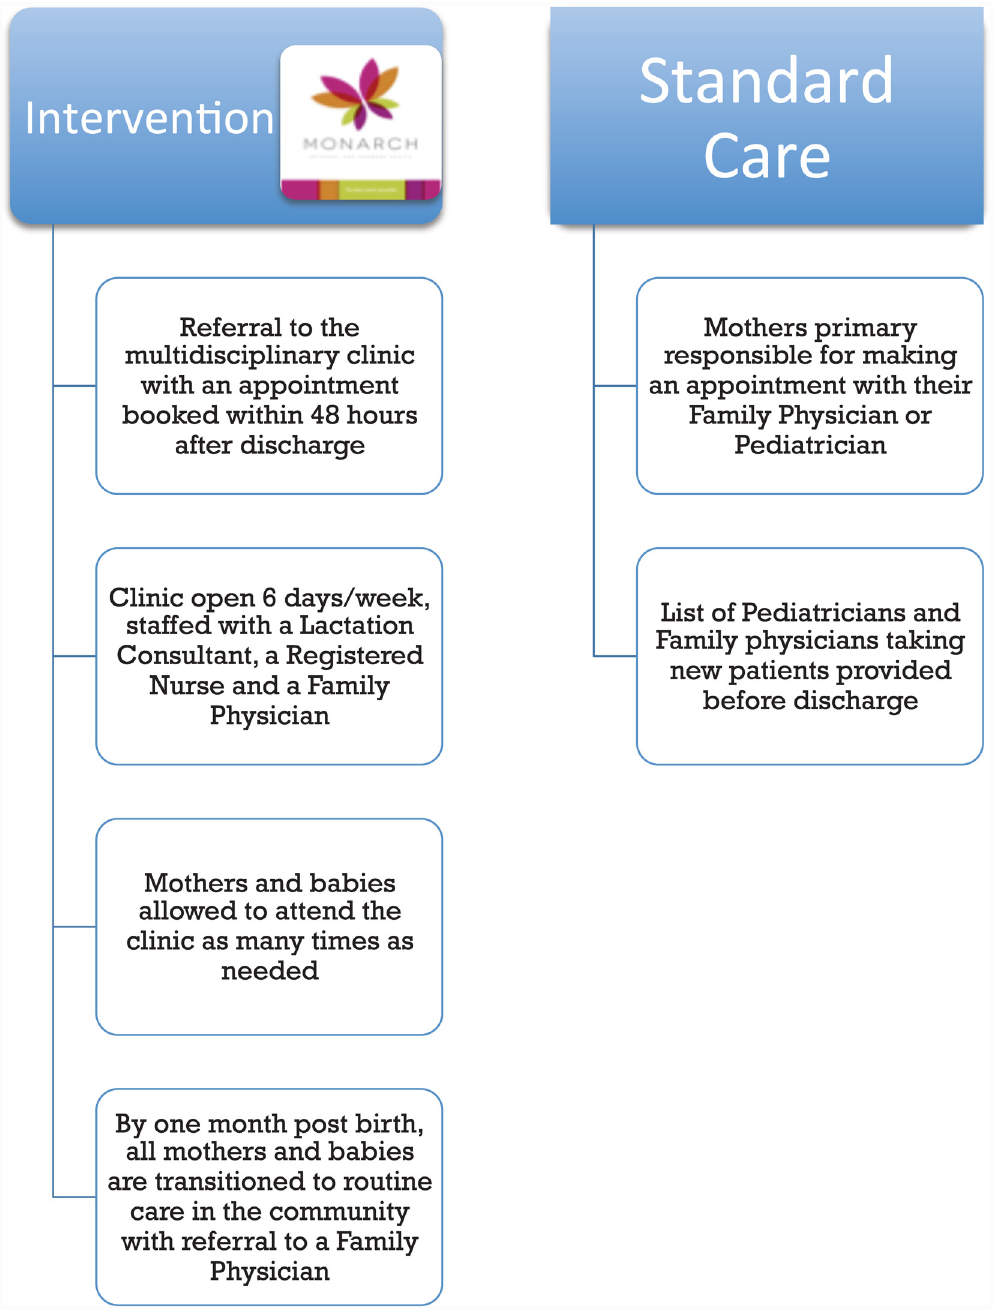
Fig 2. Flowchart comparing care received by the intervention group versus the standard of care